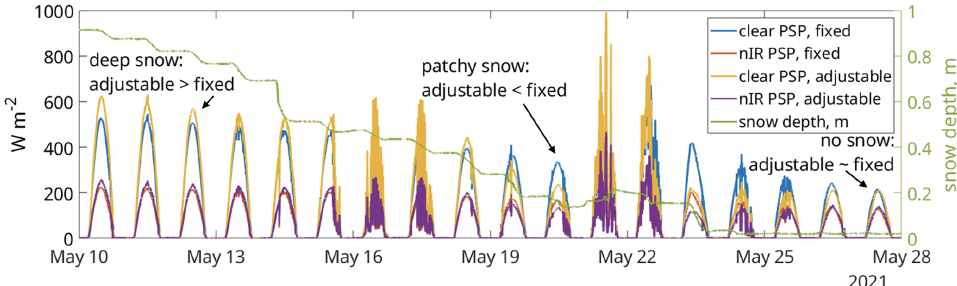
Figure 3. Reflected radiation, from downlooking radiometers, and snow depth measured at CUES.